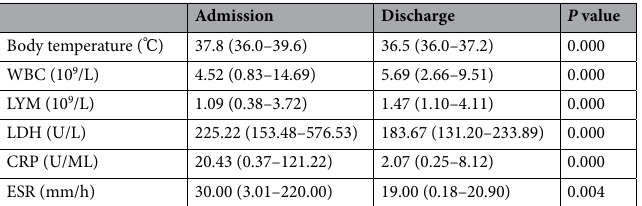
Table 2. Fever and laboratory values. The body temperature, WBC, LYM, LDH 、 CRP 、 ESR at discharge, excluding the 2 deaths. p < 0.05 was considered statistically